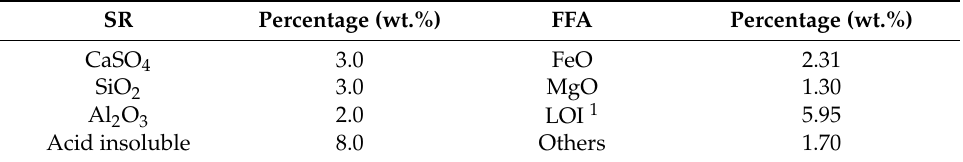
Table 1. Chemical compositions of soda residue (SR) and low-calcium fly ash (FFA) [24]. SR Percentage (wt.%) Table 1. Cont.